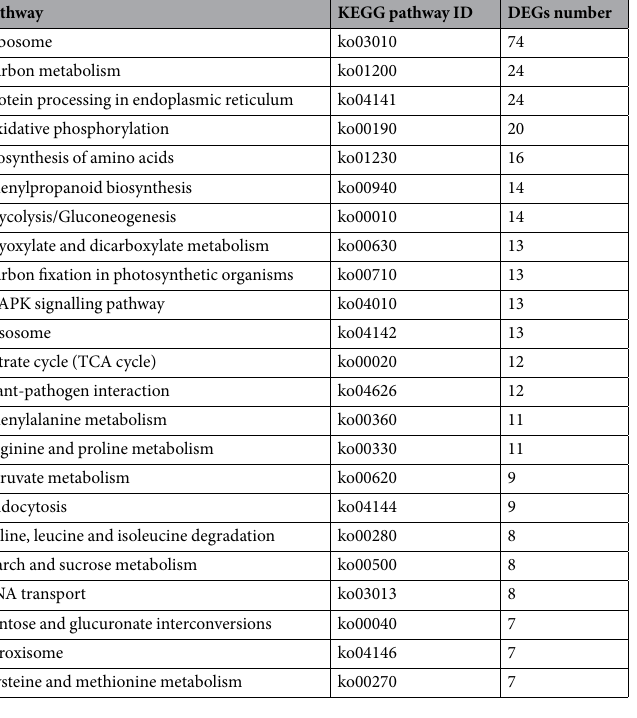
Table 3. Main KEGG enriched pathway of differentially expressed genes (DEGs) in drought-sensitive Corchorus capsularis